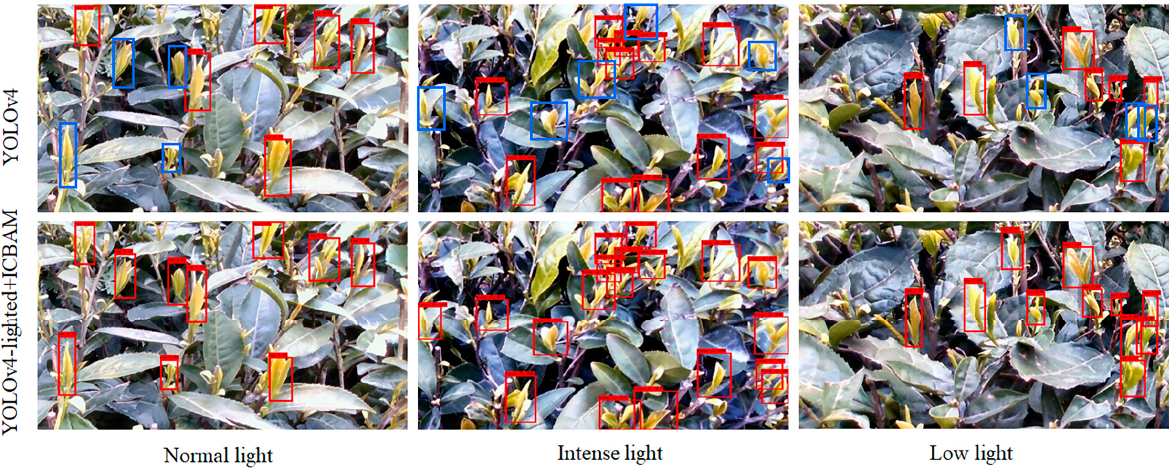
Figure 11. Tea bud detection results of YOLOv4 and YOLOv4-lighted + ICBAM, where the spatial location of each detected tea bud is described by a bounding box. A red box means a hit, whereas a blue box means a miss.